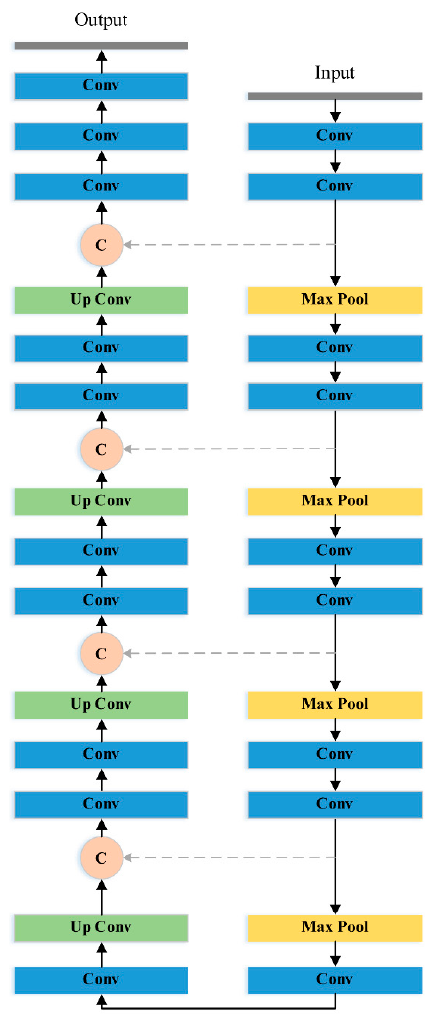
Figure 2. The network structure of SED-1 (U-Net) (Orange circle C means direct